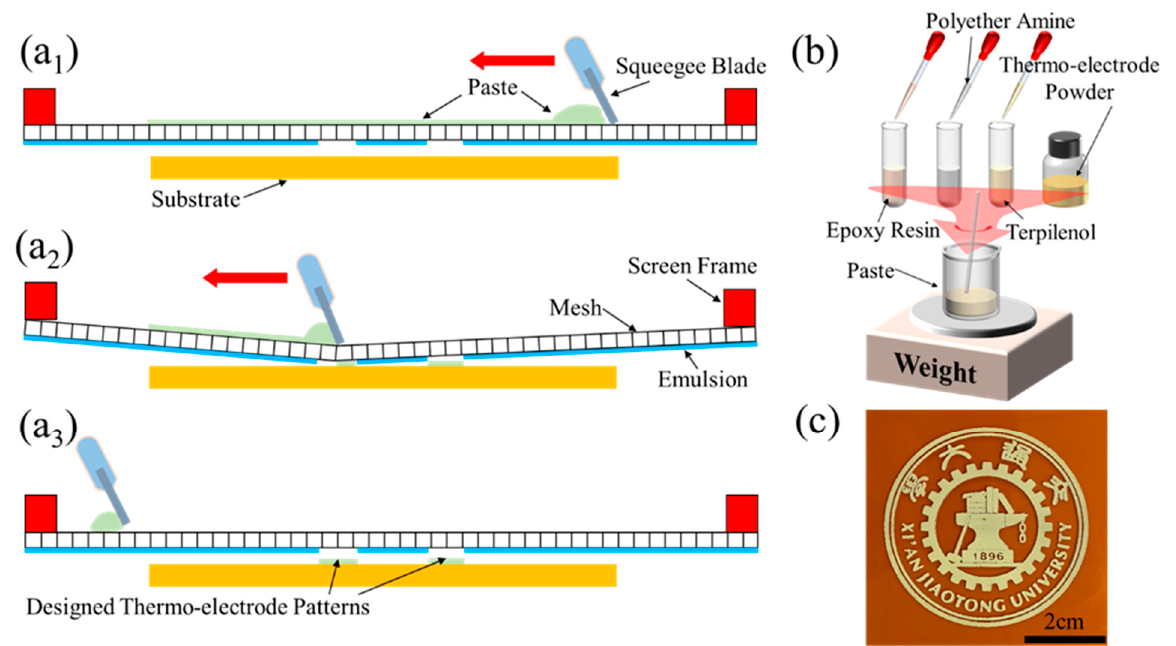
Figure 1. Illustration of pattern deposition by applying screen printing technology: ( a ) Flowchart of printing a layer of thermo-electrode on the flexible polyimide substrate. The slurry was proportionally prepared indium oxide/indium tin oxide powder; ( b ) Slurry preparation. Here, epoxy resin was a bisphenol-A type resin with an average epoxy value of 0.51. Polyether amine (D-400) was a type of polymer with the main chain of polyether structure. The terminal active functional groups in the structure were amine groups. The molecular weight was 400; ( c ) Design patterns prepared by applying screen printing technology.